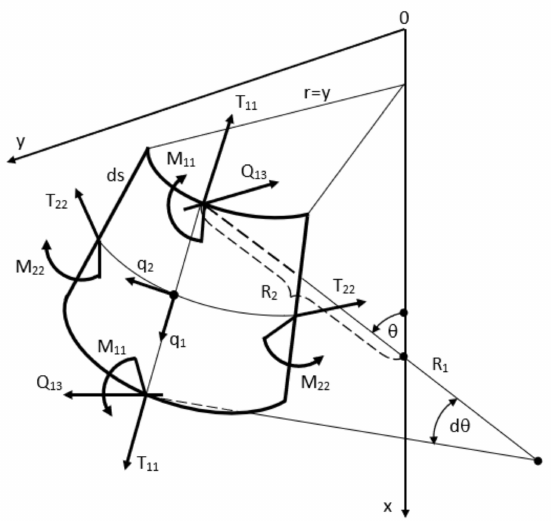
Figure 2. Cross-section of the shell. Distributed force factors, load components, and their